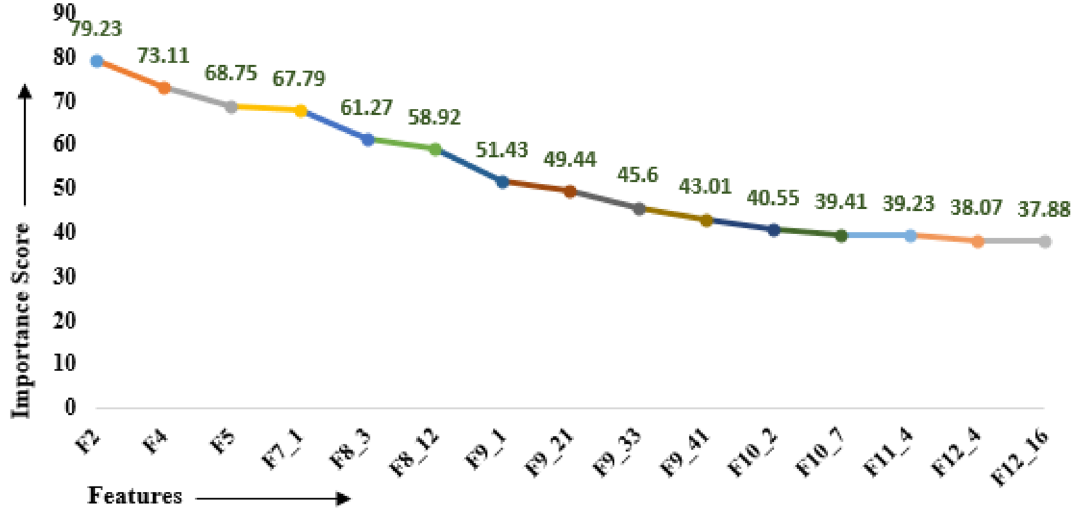
Figure 2. Feature importance line